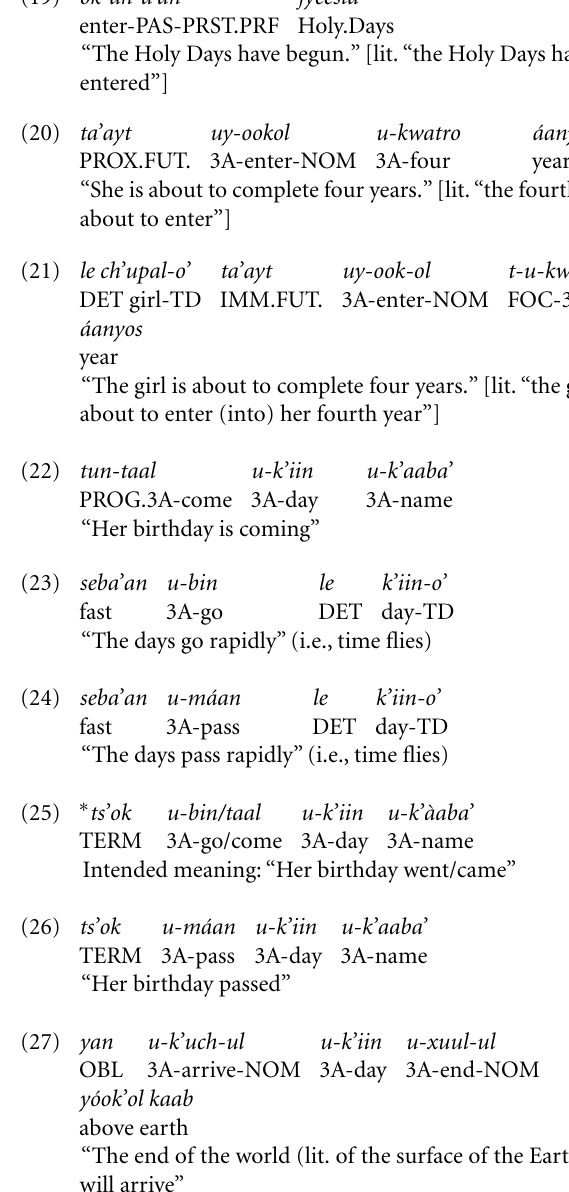
“The end of the world (lit. of the surface of the Earth) will arrive” Apparent mismatches in space-to-time metaphors Although we have shown that spatial metaphors for time are